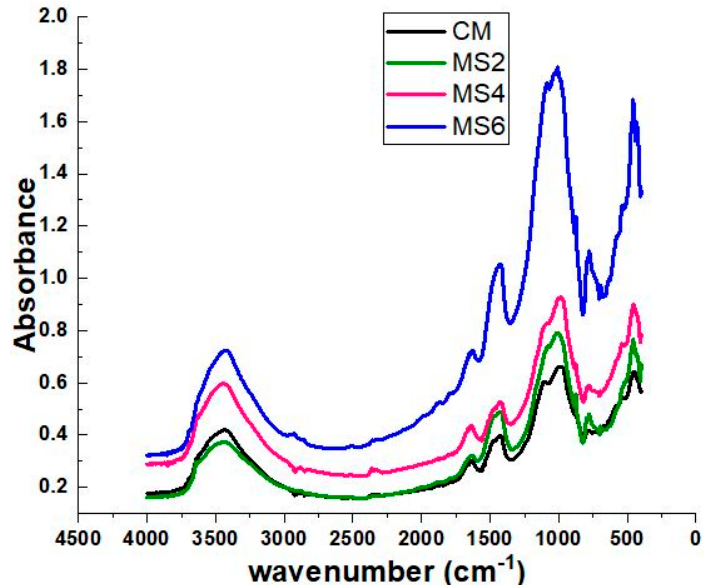
Figure 11. FTIR spectra of control concrete (CM), and air cured polymer concrete containing 10% (MS2), 20% (MS4), and 30% (MS6) sea sand at the age of 28 days.